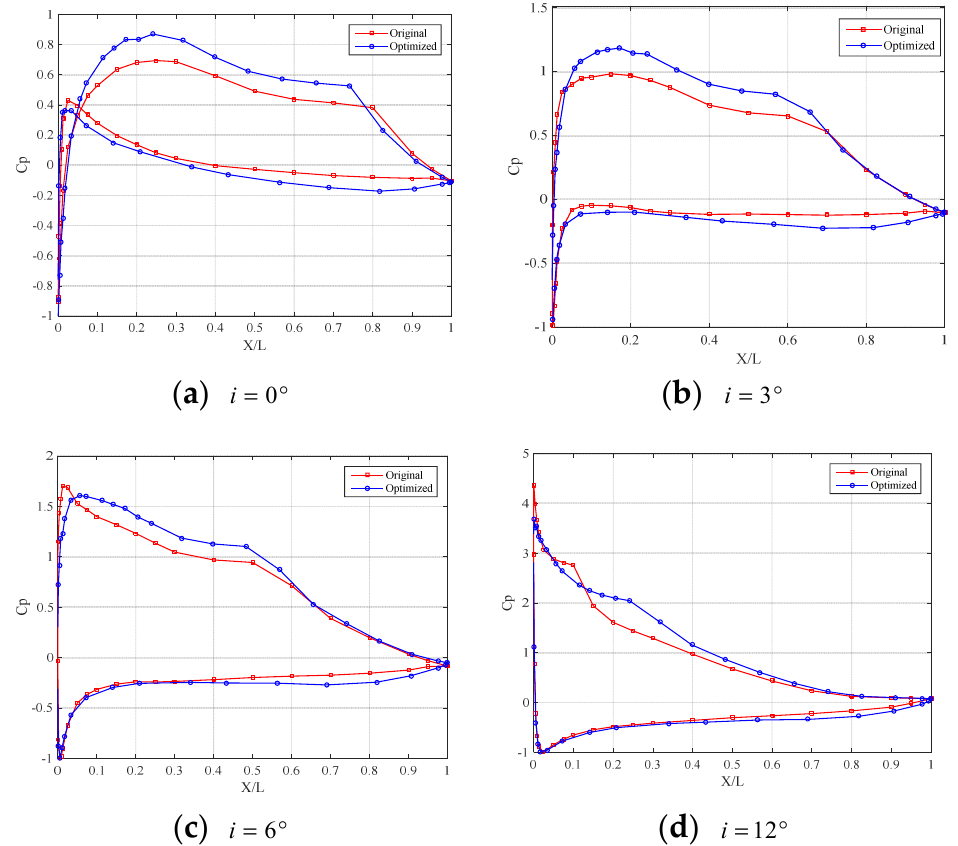
Figure 8. Surface pressure distribution comparison in multi-point optimization.